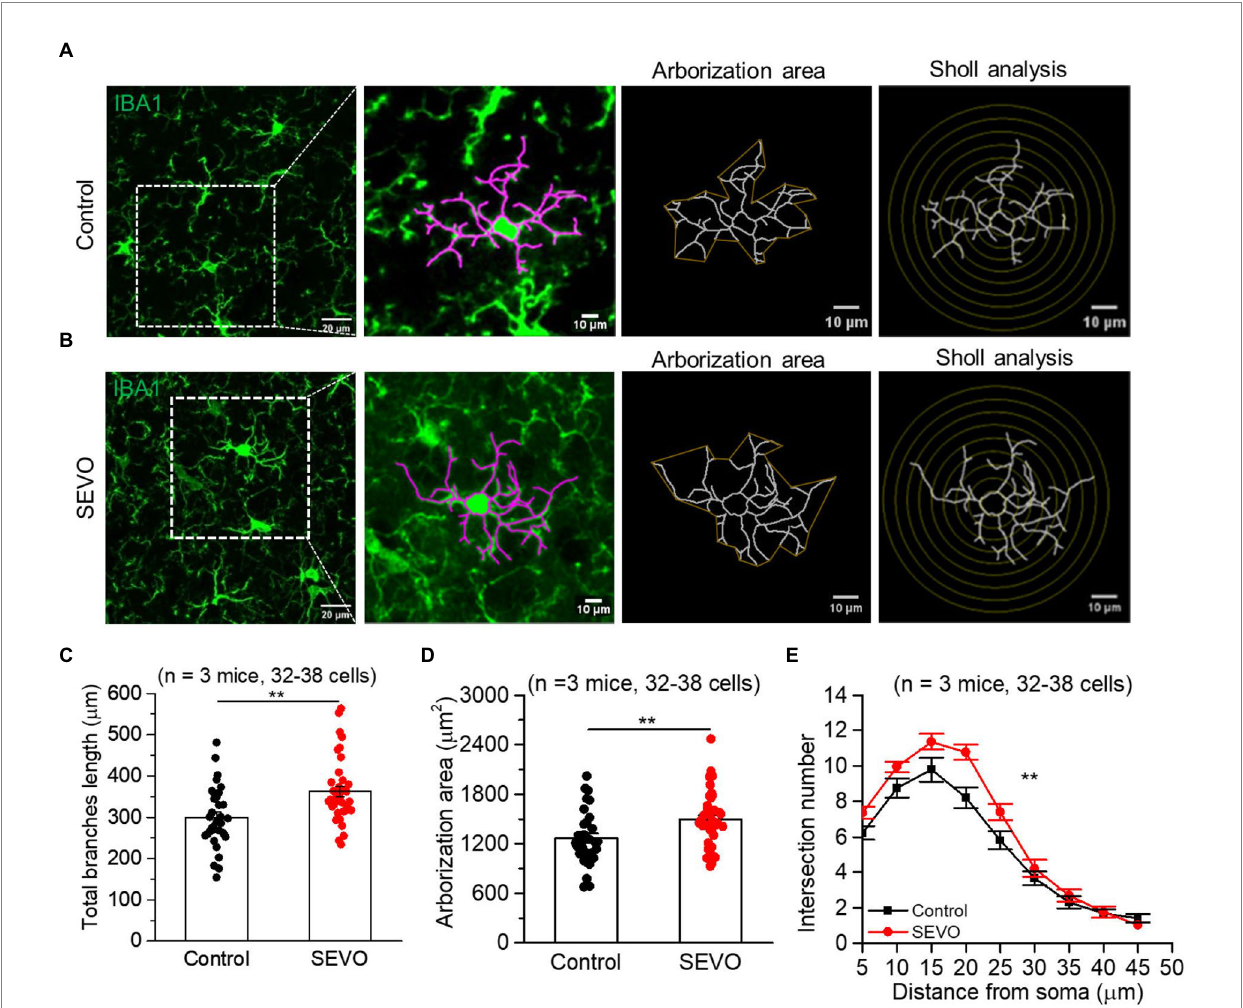
FIGURE 2 Two-dimensional morphology of microglia 14 days after prolonged neonatal sevoflurane exposure. (A,B) Representative images of IBA1-labeled microglia in the control group and SEVO group 14 days after prolonged neonatal sevoflurane exposure. (C) Quantification of the total length of microglia branches 14 days after prolonged neonatal sevoflurane exposure ( p = 0.001, two-sample t- test). (D) Quantification of the arborization area of microglia 14 days after prolonged neonatal sevoflurane exposure ( p = 0.005, two-sample t- test). (E) Sholl analysis of microglial morphology 14 days after prolonged neonatal sevoflurane exposure ( p = 0.003, two-sample t -test). Data are shown as mean ±